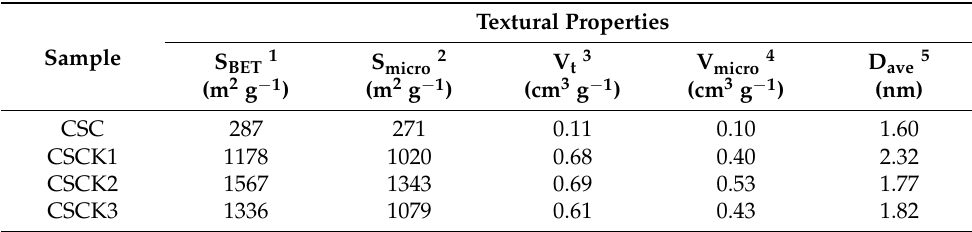
Table 1. Textrual properties of CSC and CSCKs.